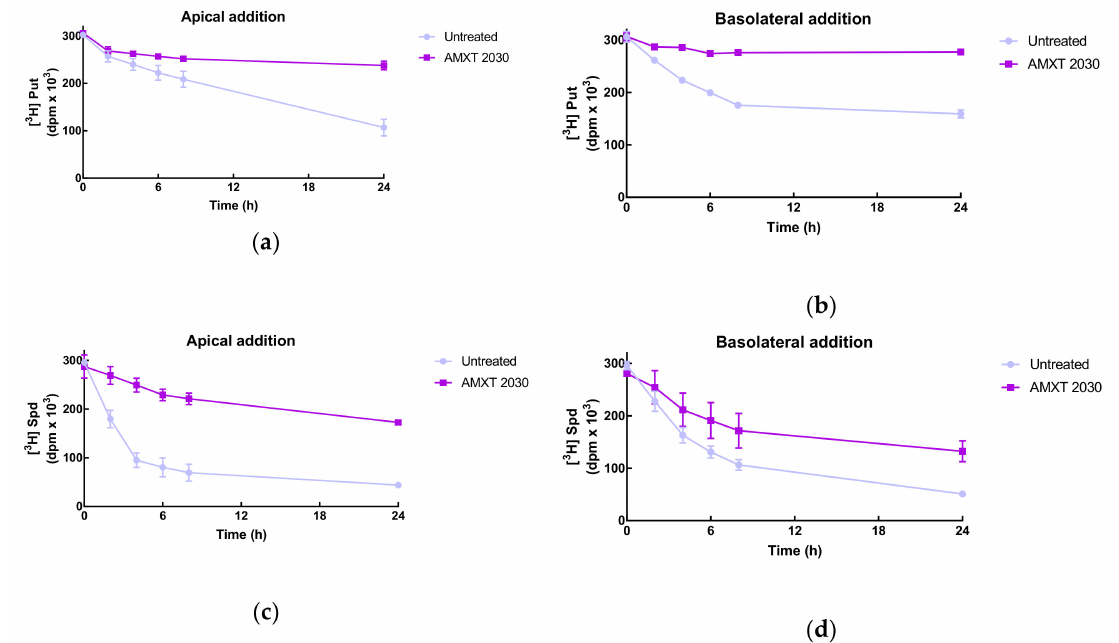
Figure 4. Putrescine (a,b) and spermidine (c,d) uptake from both sides of a Caco-2 cell monolayer. Cells were seeded at 10.0 × 10 4 cell / cm 2 in polycarbonate membrane transwell inserts in 12-well plates and grown for 14–16 days until the transepithelial electrical resistance (TEER) reading was consistently between 750–850 ohms. At this time, radiolabelled polyamine at a final radioactivity of 5.00 kBq / well (2.2 nM for putrescine or 5.0 nM for spermidine) was added with or without AMXT 2030 (10:1 ratio, 10.13 µ M for putrescine, 23.5 µ M for spermidine) into either the apical or basolateral chamber. This time was set as t = 0 h. Medium in 5 µ l aliquots from each chamber were taken to measure total radioactivity by liquid scintillation spectrometry at regular intervals. Values are mean ± SEM when n ≥ 3 or range when n < 3. (Controls n = 3, AMXT n =